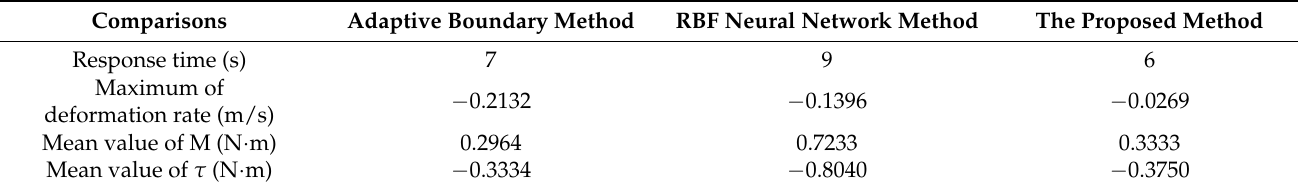
Figure 7. The control input τ and M results of different methods: ( a ) adaptive boundary method; ( b ) RBF neural network method; ( c ) the proposed method.